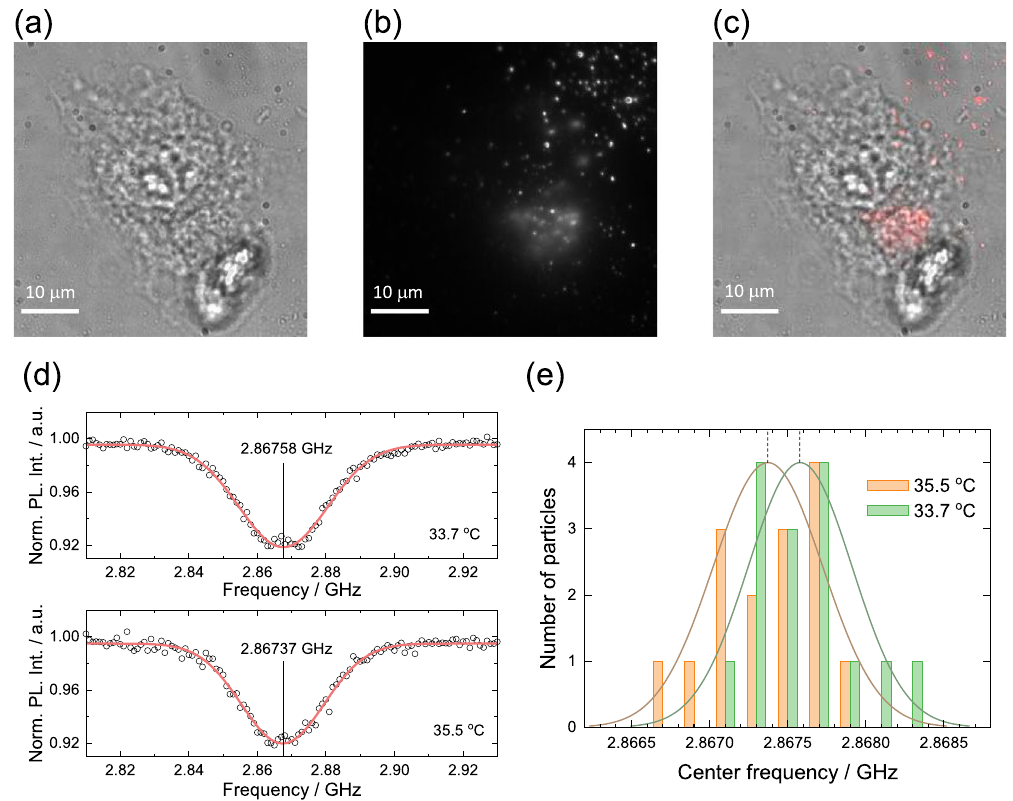
Figure 7. Microscope images of the ND-labeled HeLa cells; ( a ) bright field ( b ) red fluorescence, and ( c ) merged. Scale bar: 10 µ m . ( d ) ODMR spectra averaged over 15 NDs in the cell at T d = 35.5 (bottom) and 33.7°C (top). ( e ) Histograms of the center frequency of 15 NDs at the two temperatures with normal distribution fitting. n acc = 50 and (cid:31) t exp = 10 ms were used for all the